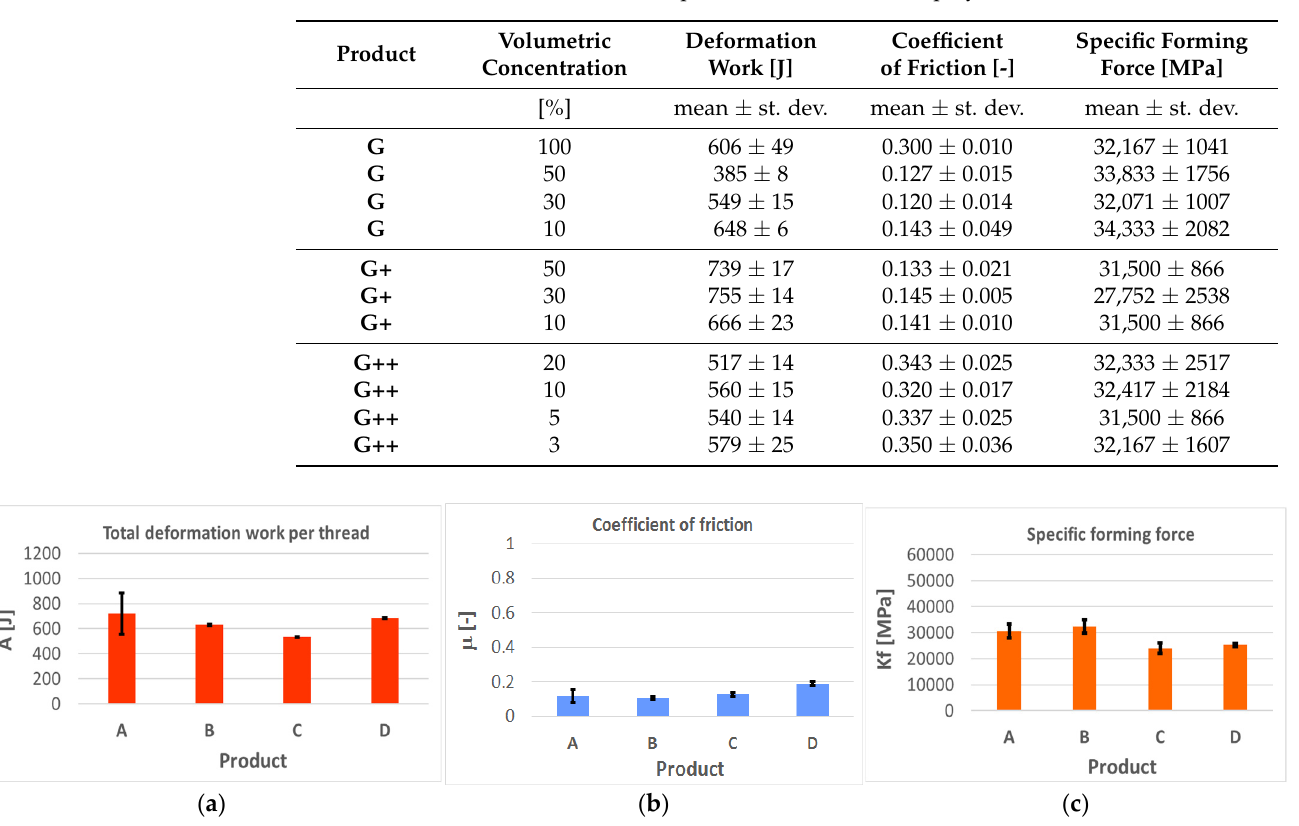
Table 7. An overview of the measured parameters for the tested polymer G , G+ , and G++ .